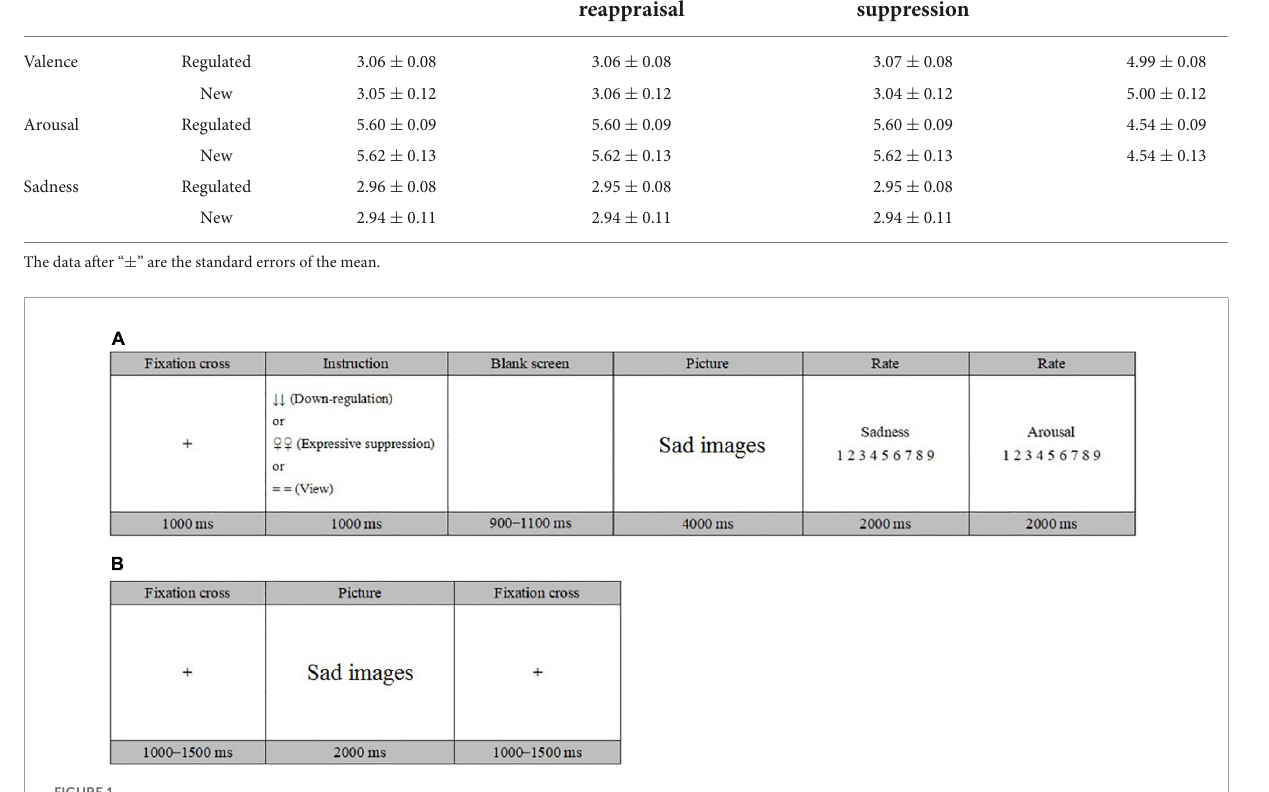
response (Paul et al., 2013). Before the formal experiment, the participants were made familiar with the experimental procedure and keystroke responses through